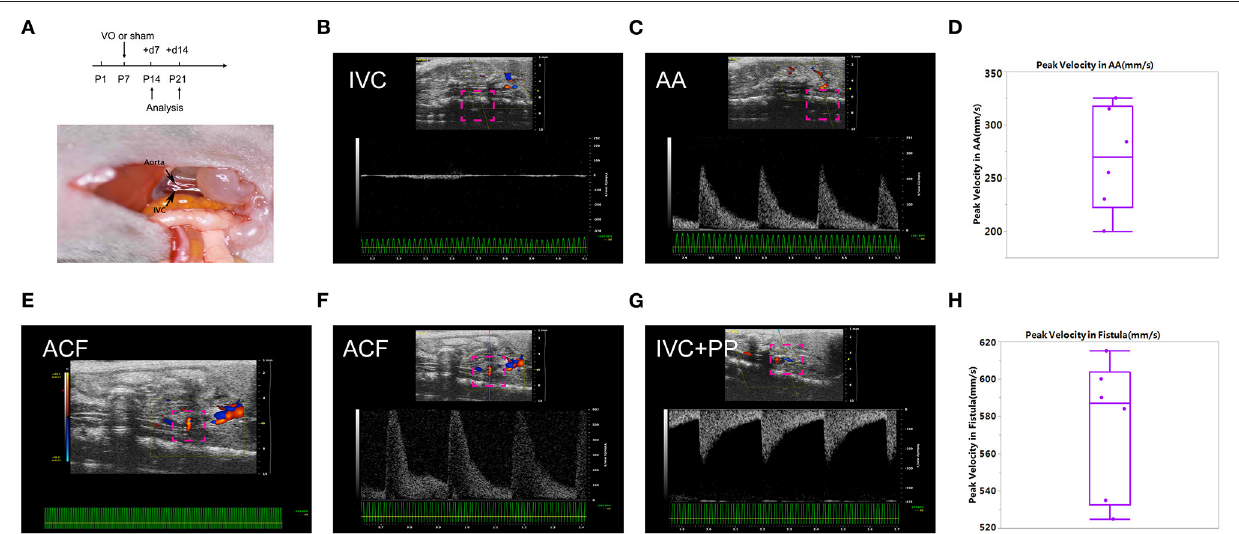
FIGURE 1 | Establishment of the aortocaval fistula (ACF). (A) Top panel: experiment protocol; bottom penal: schematic diagram of the ACF model. (B) No pulsatile blood flow appears in the inferior vena cava (IVC). (C) Pulsatile blood flow is shown in the abdominal aorta (AA), with a peak blood flow velocity of 250 mm/s. (D) Quantification of peak velocity in the AA. (E) A representative image of blood flow through the fistula. (F) The representative image of pulsating blood flow at the fistula, with a peak blood flow velocity of 602 mm/s, which is higher than that of the AA. (G) Pulsatile blood flow appeared in the IVC after fistula establishment, with a peak blood flow velocity of 280 mm/s. (H) Quantification of peak velocity in the fistula. n = 6 mice.